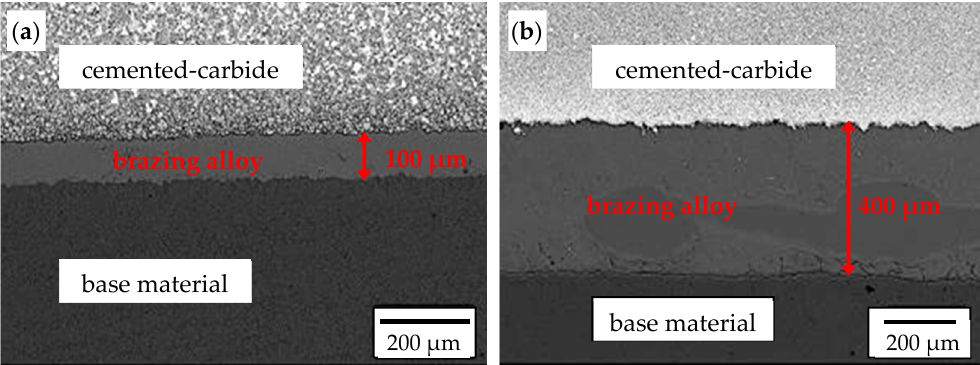
Figure 9. Cross section of the brazed joint of the cemented-carbide plate with the base material: ( a ) chisels A and ( b ) chisels B. SEM, BSE detector.